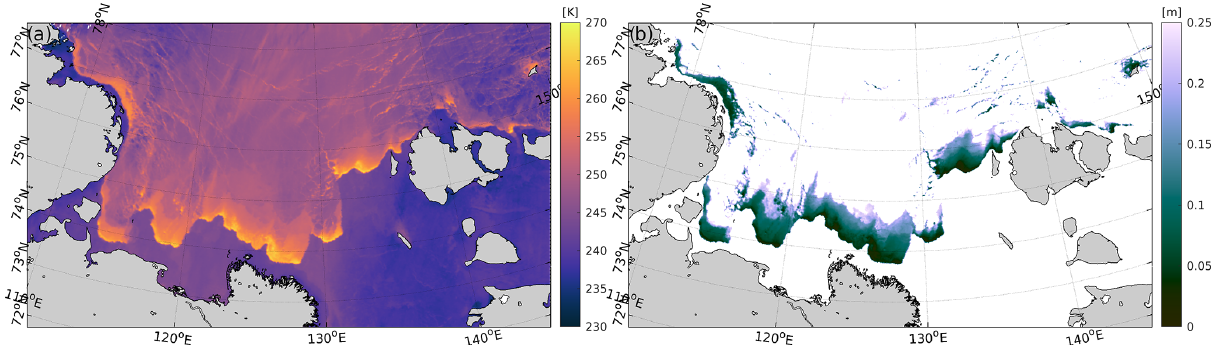
Figure 3. Example of MODIS ice-surface temperature ( IST in K; a) and its associated thin-ice thickness ( TIT; b) between 0 and 0.25m, as acquired on 5 March 2011 at 18:10UTC.